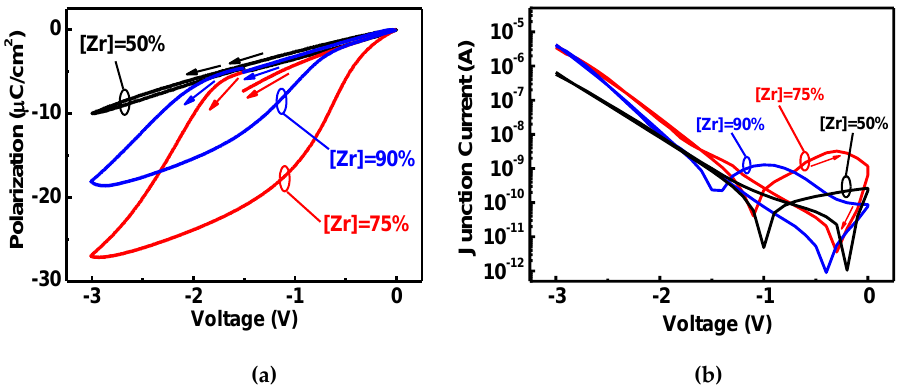
Figure 8. The HZOs with the [Zr] = 50%, 75%, and 90% diodes for the unipolar sweep ( − 3 V to 0 and back to − 3 V) for the ( a ) P-V and ( b ) I-V characteristics. The [Zr] = 75% and [Zr] = 90% for the AFeCAPs exhibit the “typical” ferroelectric behavior with unipolar operation. There is paraelectric behavior for [Zr] = 50%. The much higher polarization and ferroelectric-based current are obtained for AFE diodes with unipolar operation.